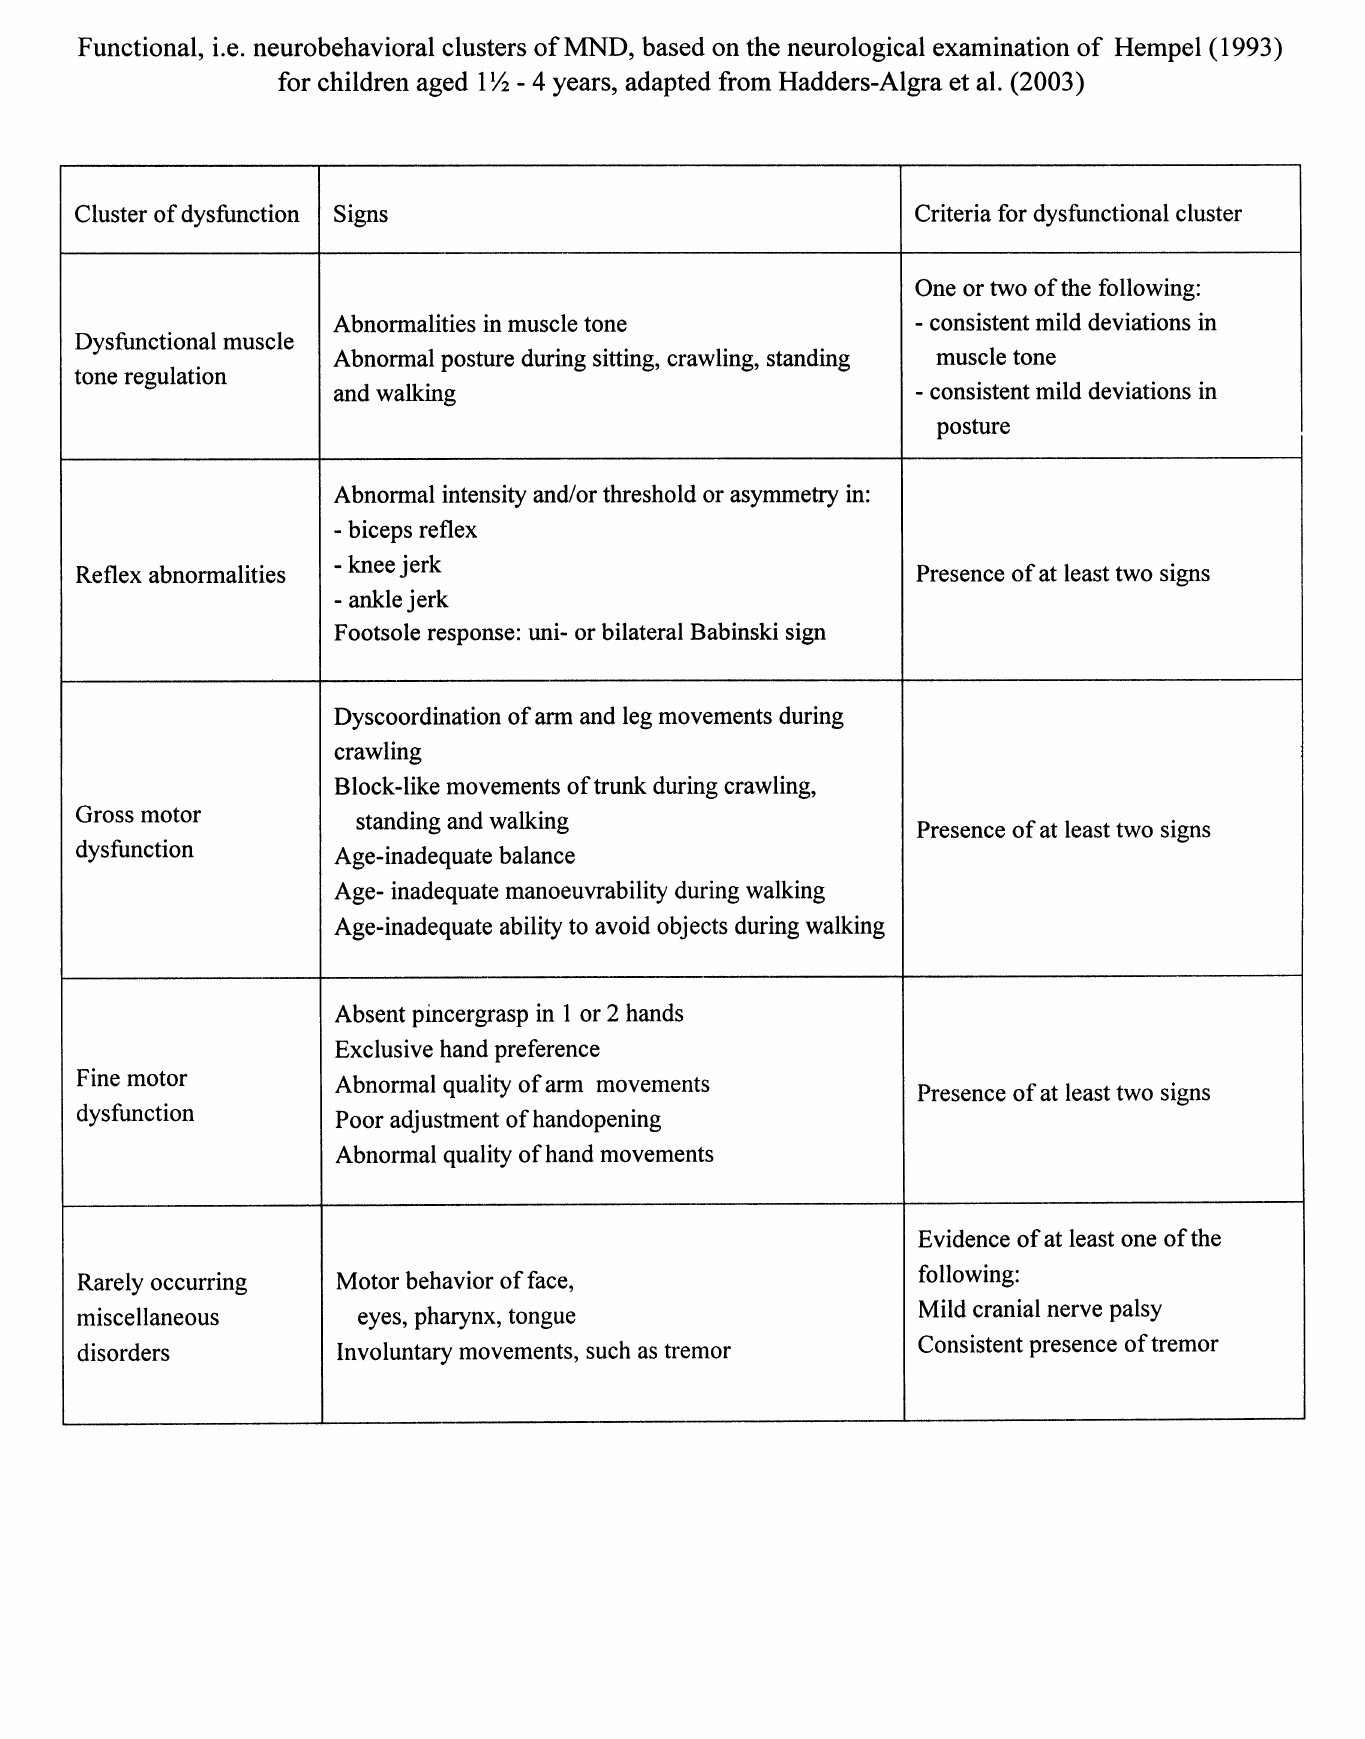
Functional, i.e. neurobehavioral clusters of MND, based on the neurological examination of Hempel (1993) for children aged 11/2 4 years, adapted from Hadders-Algra et al.